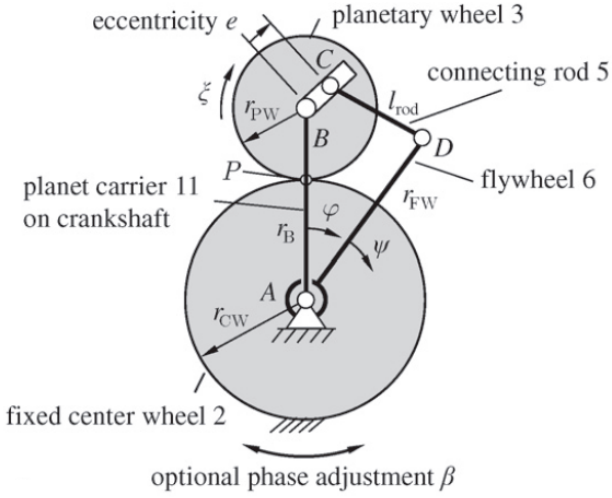
Figure 10. Mechanism topology of the proposed KDF [27]. Figure is reprinted with permission from publisher.